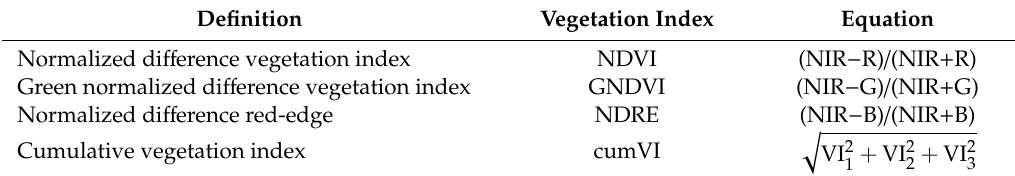
Table 1. Definition, acronyms, and equations of the vegetation indices used in the study. Cumulative vegetation index (cumVI) was calculated for each vegetation index present in the table (VI) at